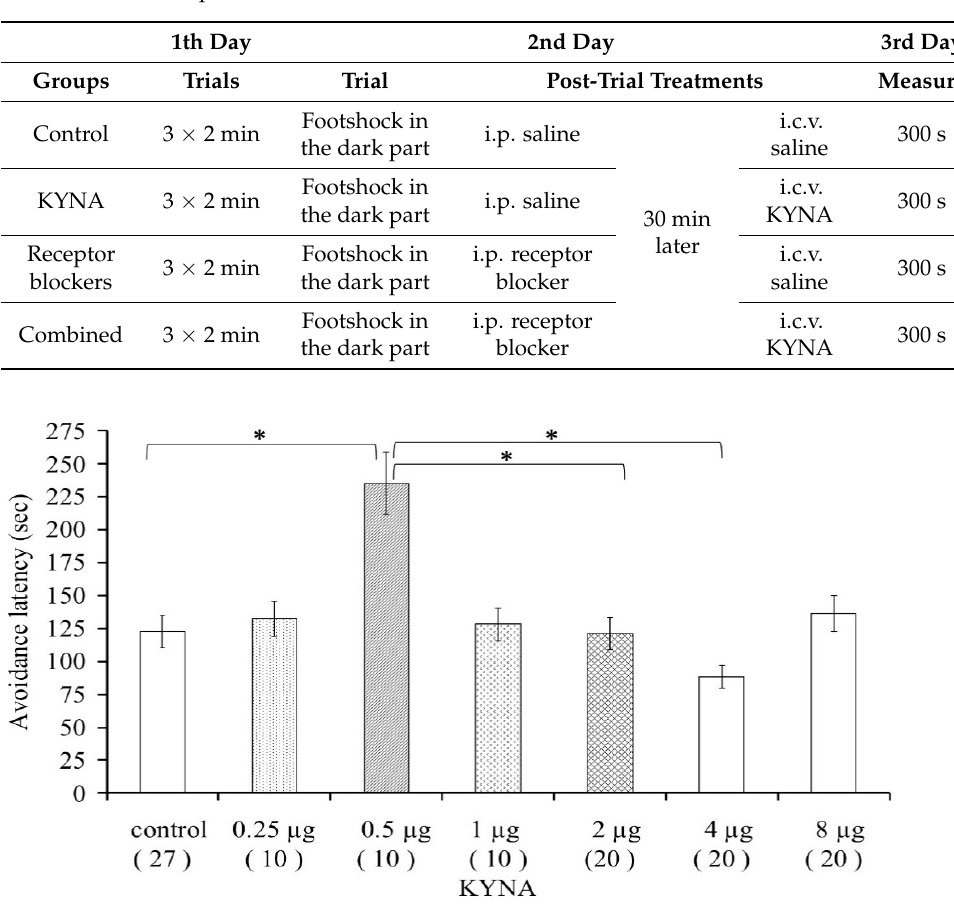
Table 1. Protocol of passive avoidance test and treatments.